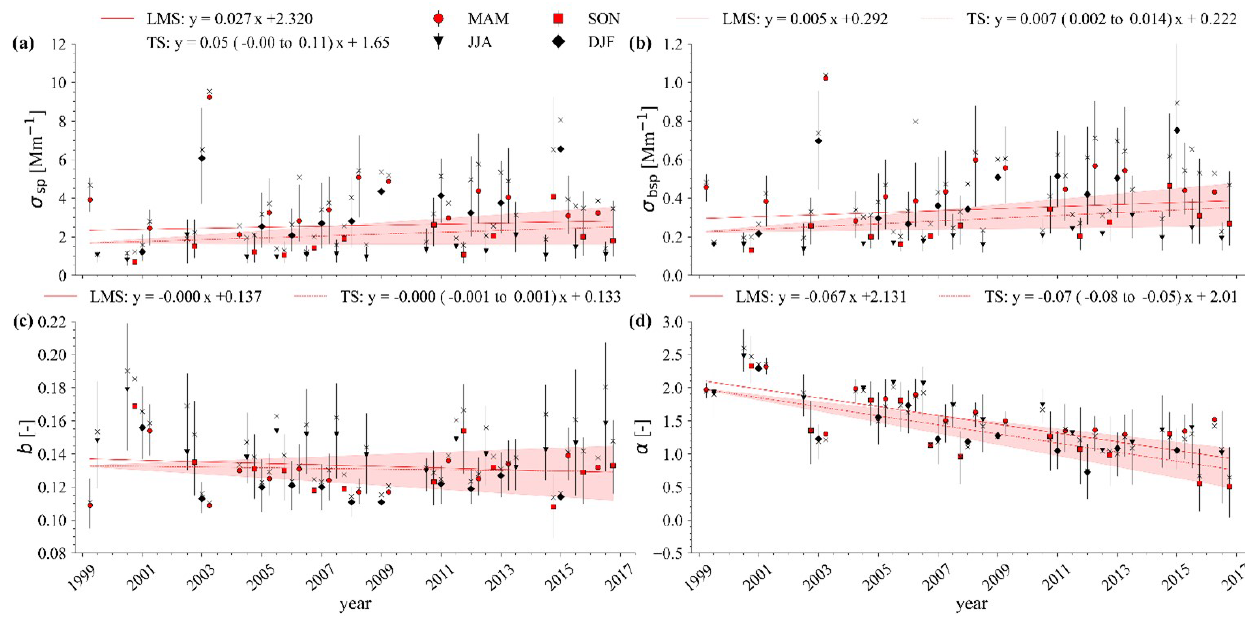
Figure 11. Long-term trends of the seasonal medians for (a) the particle light scattering coefficient (wavelength, λ = 550nm), (b) the particle light backscattering coefficient ( λ = 550nm), (c) the hemispheric backscattering fraction ( λ = 550nm), and (d) the scattering Ångström exponent ( λ 1 = 450nm, λ 2 = 550nm). The seasonal medians are denoted by their respective symbols. The error bars denote the length of the 25th- and 75th-percentile values. The seasonal mean is given by the cross. The solid and dashed red lines represent the least mean squares (LMS) and Theil–Sen slope (TS) of the seasonal medians, respectively. The red-shaded area denotes the associated 90% confidence interval of the TS slope. Figure taken from Heslin-Rees et al. (2020). Table 5. Selected greenhouse gases measured at the Zeppelin Observatory and their chemical formulas, global warming potentials (GWPs, CO 2 is 1), mean mixing ratios in 2019, fitted trends, and trend fit parameters (error and R 2 ). Measured from